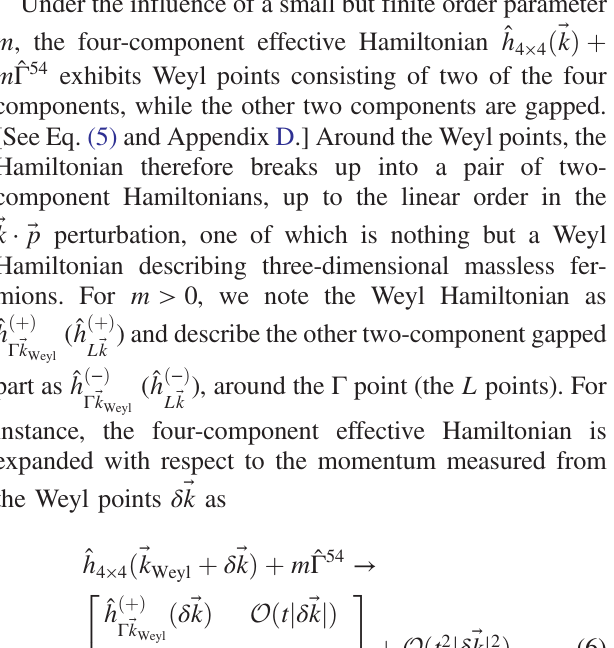
ffiffiffi p 3 ; 1 =